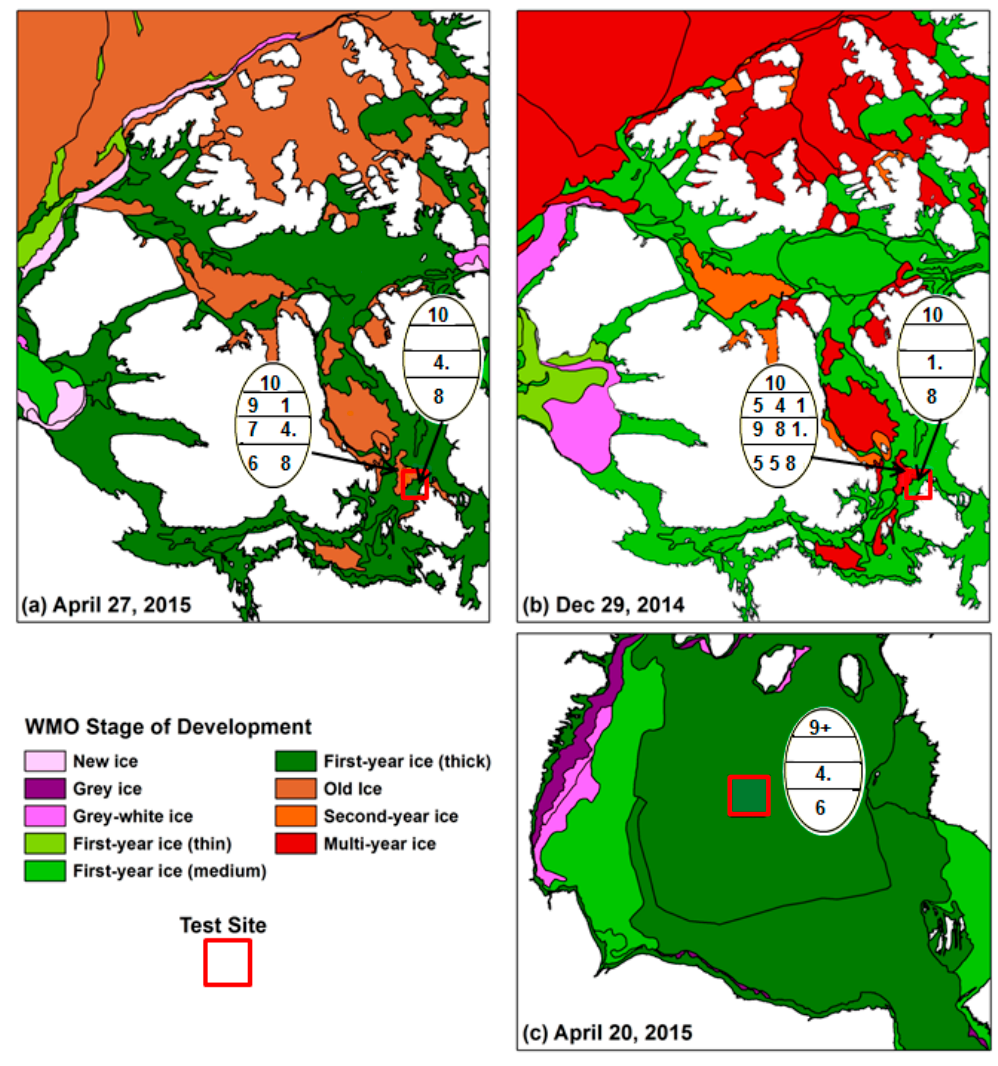
Figure 3. Ice charts of the CAA with egg-codes on ( a ) 27 April 2015 and ( b ) 29 December 2014. ( c ) Ice chart of Hudson Bay on 20 April 2015. Charts are according to the World Meteorology Organization (WMO) colors for sea ice stage of development.